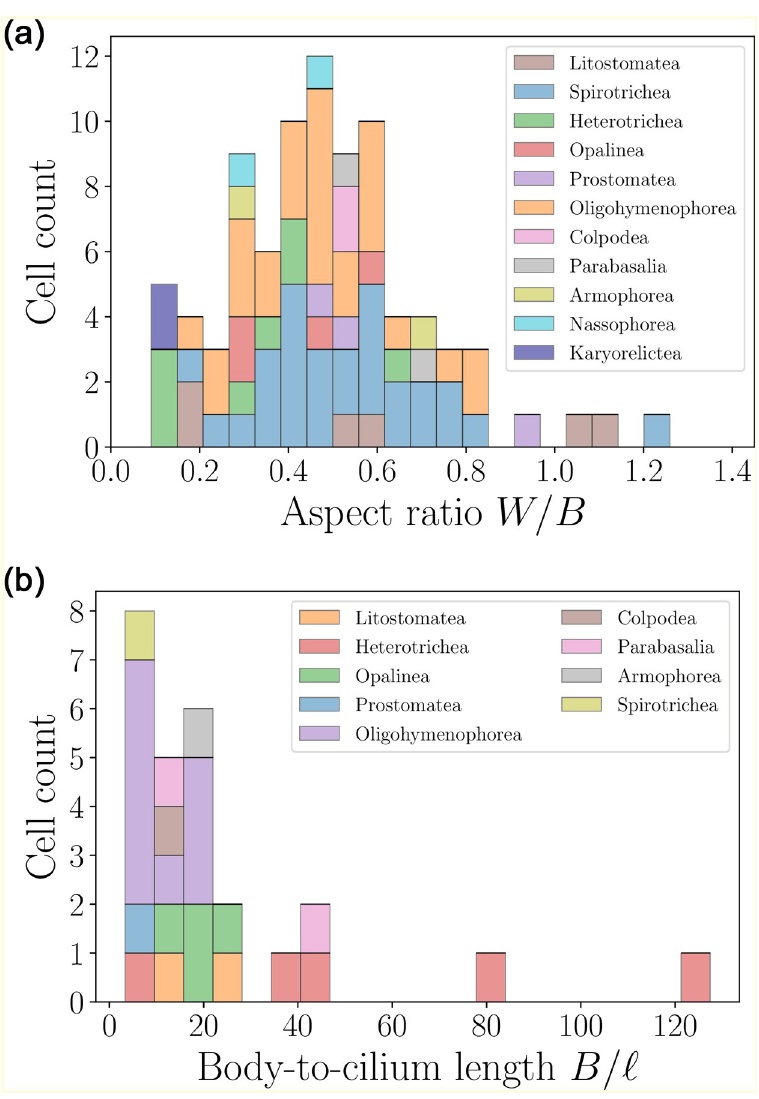
Fig 20. Histograms of aspect ratios W / B (left) and body-to-cilium length B / ℓ (right) for ciliates. Most of the cells are prolate, with the mean aspect ratio h W / B i = 0.49 ± 0.22 ( n = 86). The size-to-flagellum length ratios have average values h B / ℓ i = 23.13 ± 27.03 ( n =